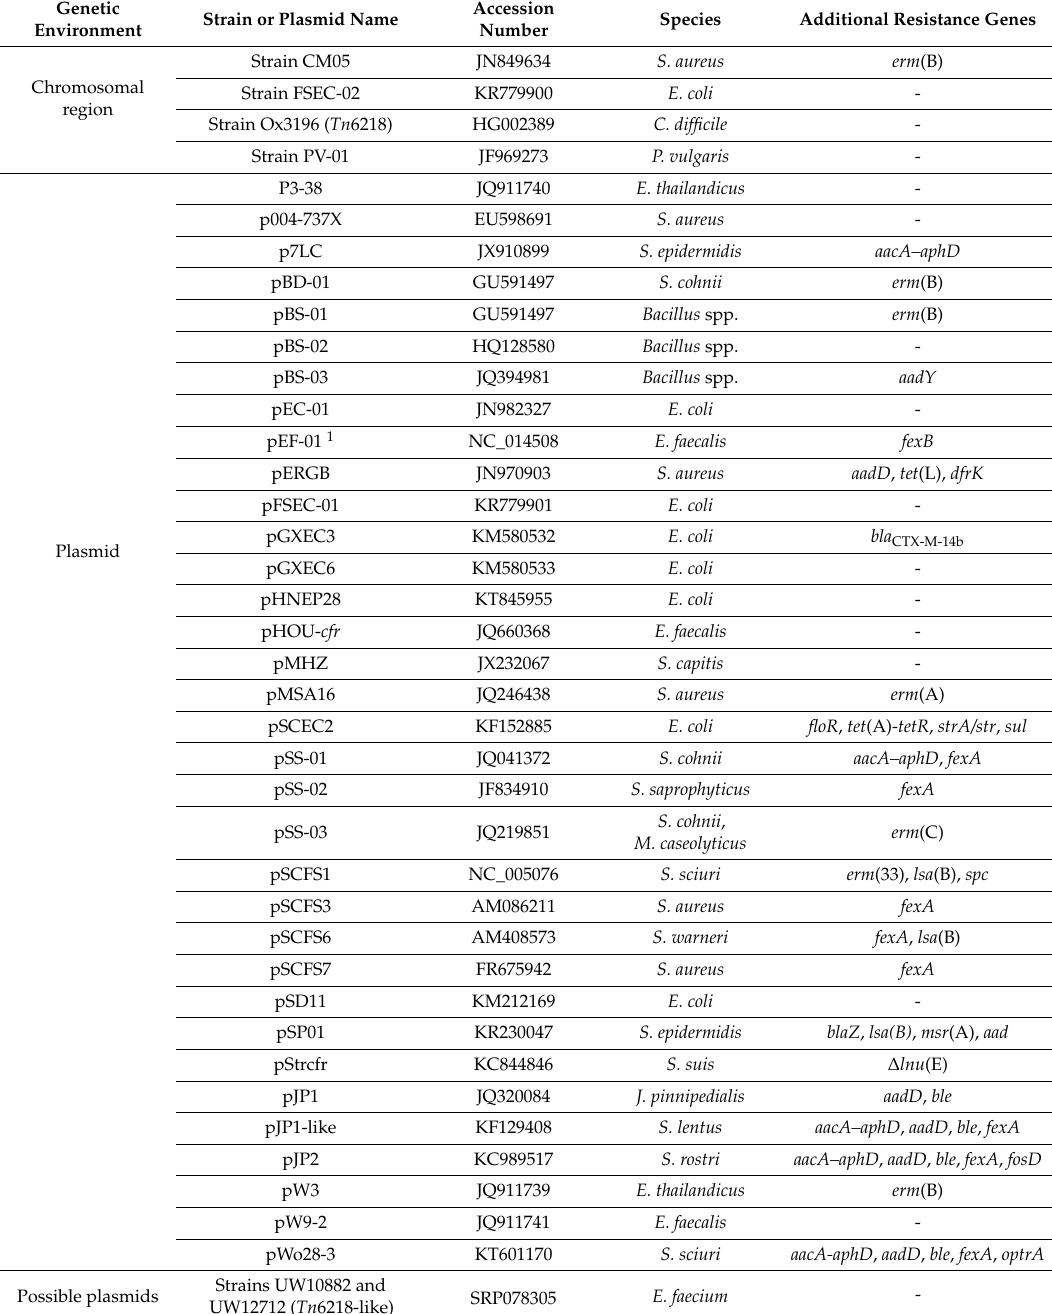
Table 4. Examples of the genetic environments of cfr